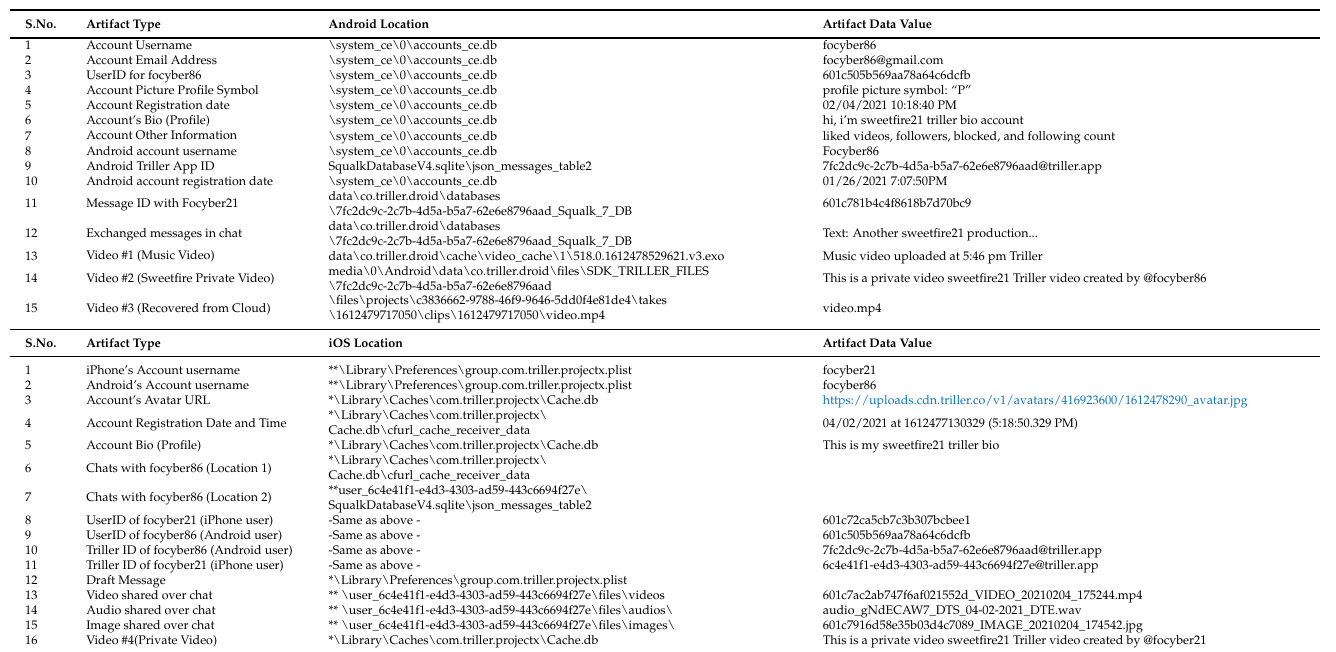
Table 8. Triller Android and iPhone